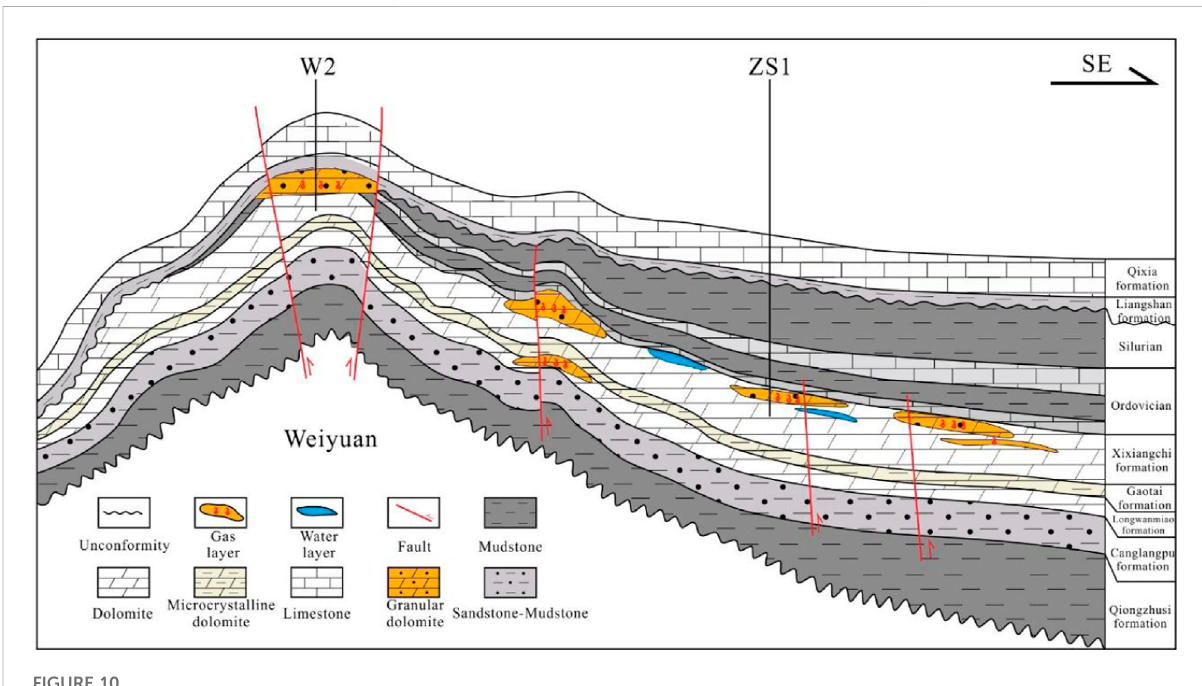
FIGURE 10 Hydrocarbon accumulation pattern in Xixiangchi Formation (Southern Sichuan